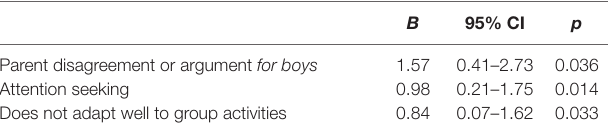
TaBle 6 | Variables associated with BPD traits in adolescents: multivariate linear regression model ( n =